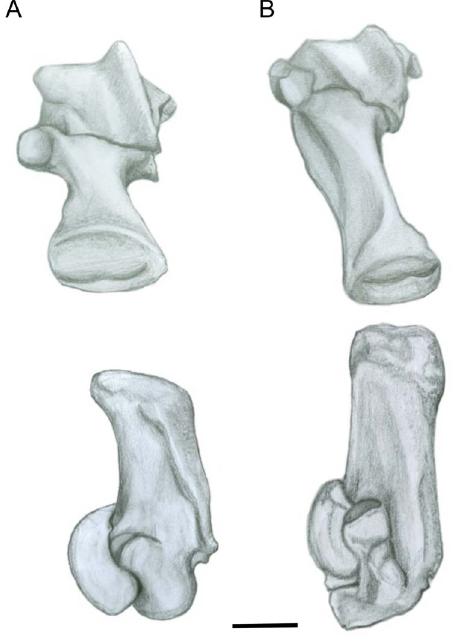
Figure 5. Tibia. (A) Procoptodon goliah (NMV2010). (B) Macropus giganteus (AMNH 2390). All left side: upper = distal articular view (plantar side upwards); lower = posterior (plantar) view, showing articulation with tarsus. Scale bar =5 cm.